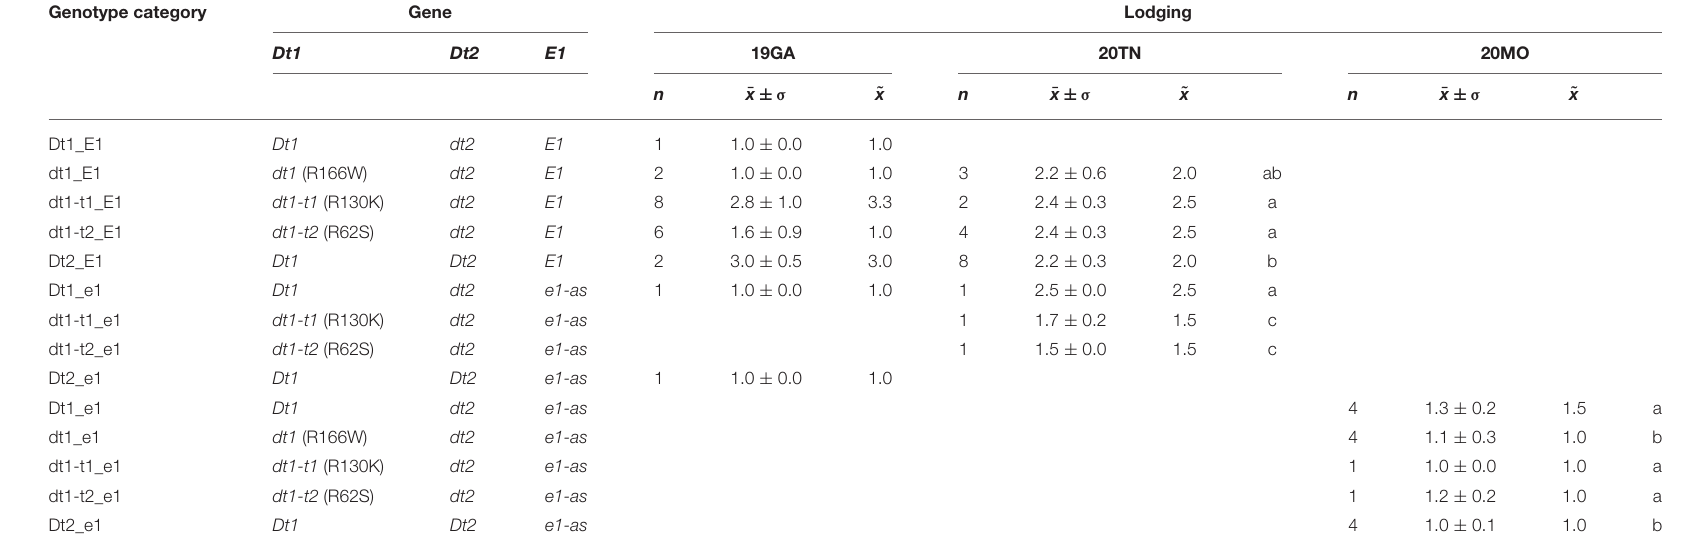
TABLE 4 | Genotypes and lodging scores of soybeans lines having allele combinations for stem termination type and maturity from field experiments at three different environments in 2019 and 2020, 19GA, 20TN, and 20MO. Genotype